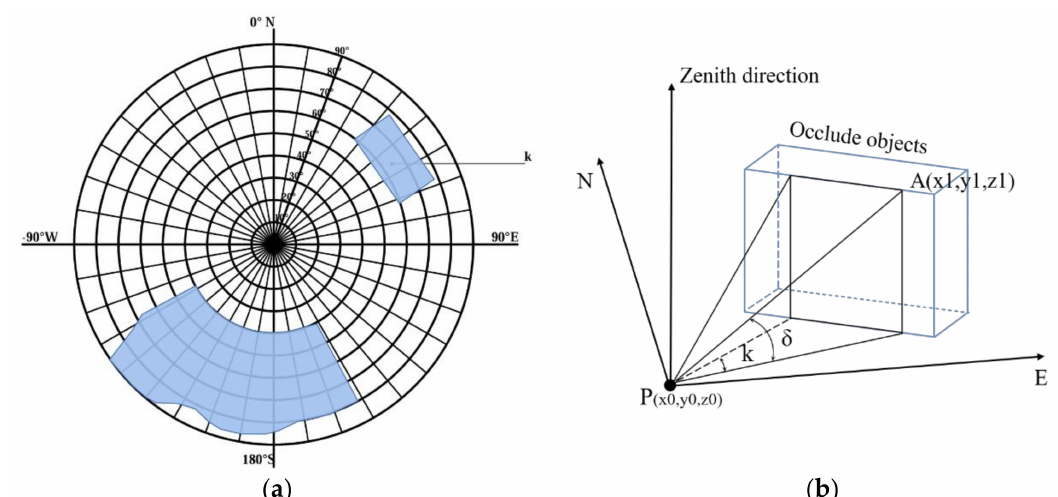
Figure 6. An illustration of the calculation of the SVF (k: azimuth angle (the angle between k and the north being k × 10 ◦ ); δ : is the maximum shading angle). ( a ) Division of the sky hemisphere at equal intervals of 10 ◦ . ( b ) Calculation of the maximum occlusion angle in the k